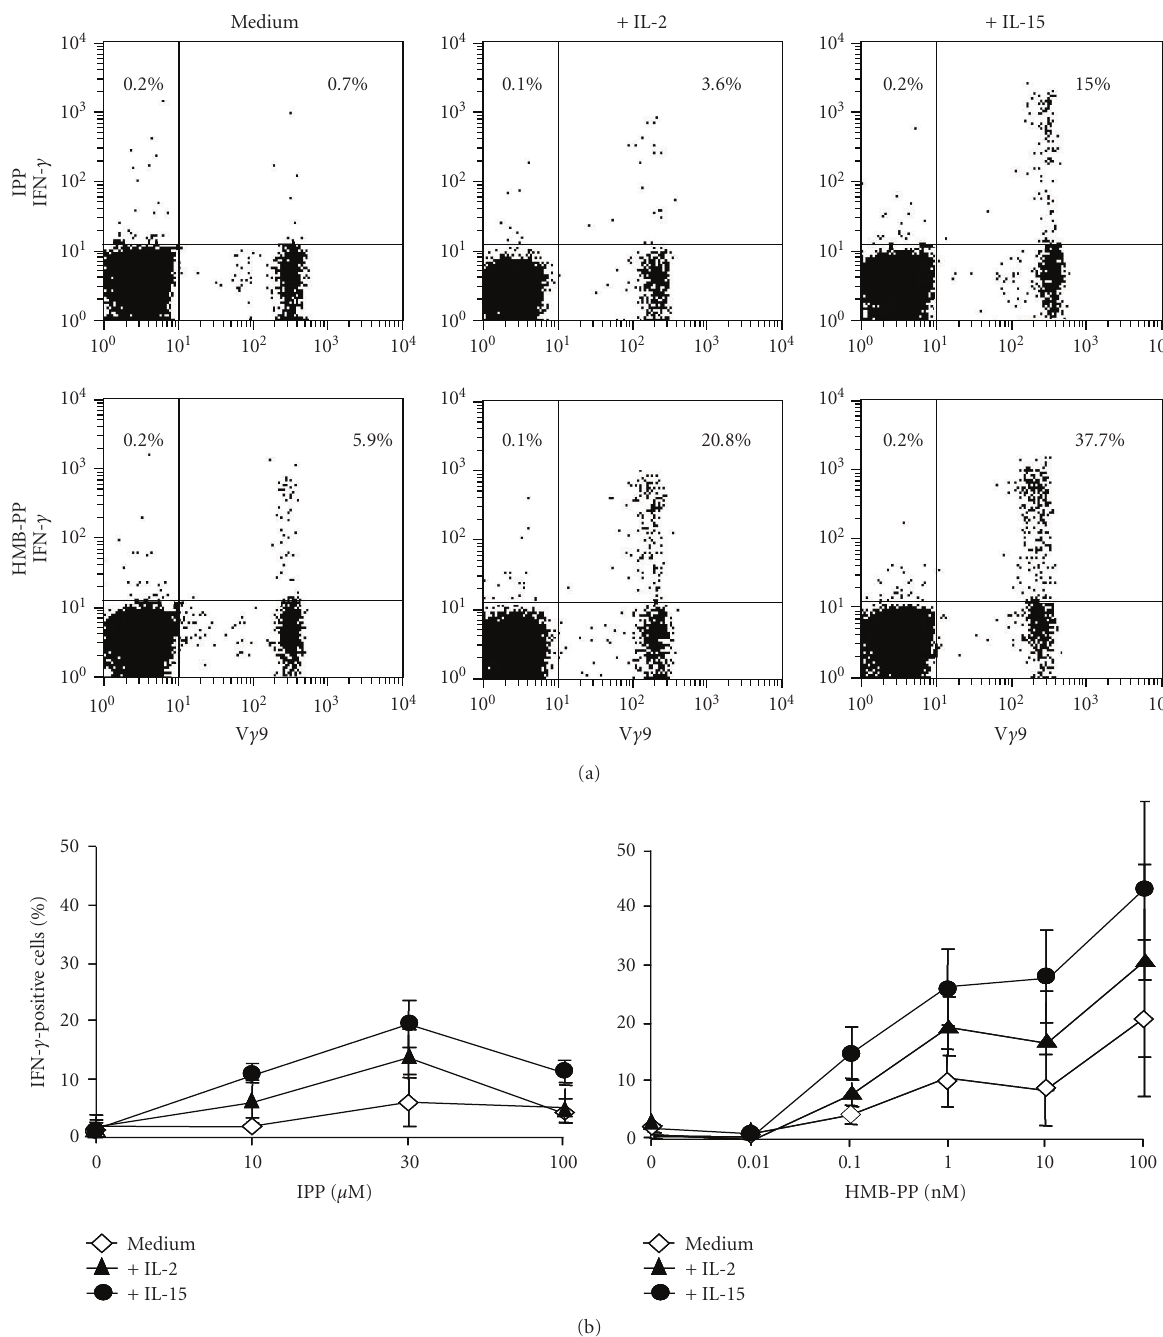
Figure 2: IL-2 and IL-15 augment IFN- γ expression by phosphoantigen-stimulated V γ 9V δ 2 T cells. (a) Representative dot plots showing IFN- γ expression by V γ 9 cells 4 hours after stimulation with IPP (10 μ M) or HMB-PP (10nM), in the absence or presence of 50U/mL IL-2 or 10ng/mL IL-15. Plots are representative of 8 independent studies. Numbers in the plots indicate the percentages of V γ 9 − (left) and V γ 9 + (right) T cells that produce each cytokine. (b) Mean ( ± SEM) percentages ( n = 8) of V γ 9 cells expressing IFN- γ after stimulation with various concentrations of IPP or HMB-PP, in the absence and presence of IL-2 and